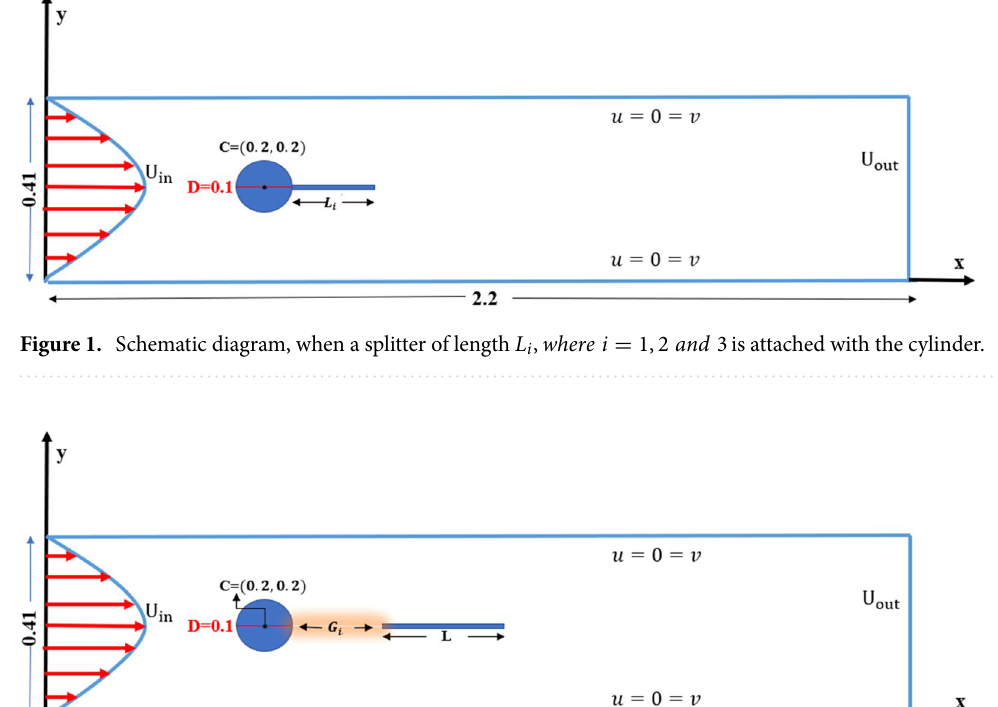
Figure 2. Schematic diagram, when a splitter of length G i , ( where i = 1, 2 and 3 ) from the